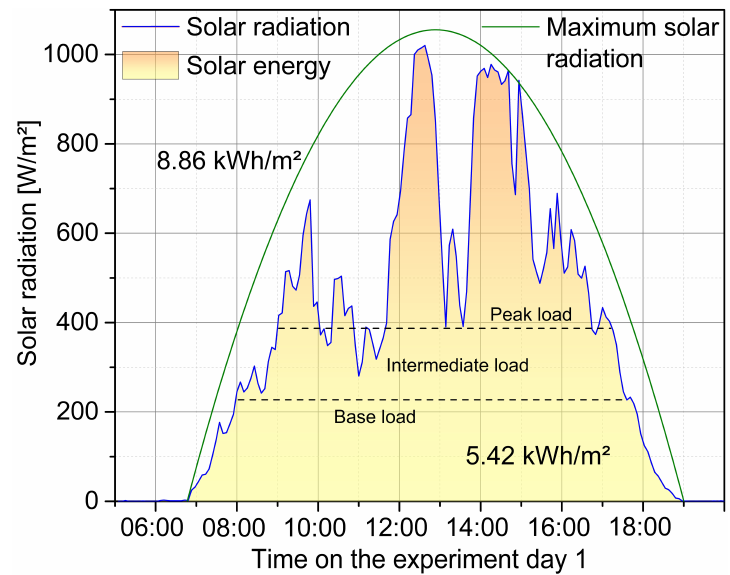
Figure 2. Measured, areal normalized solar radiation power at the site of the plant. The highest recorded value was 1020 W / m 2 . Over the entire day considered, with a total sunshine duration of approximately twelve hours, the solar radiation energy was 5.42 kWh / m 2 . Three weather- and daytime-dependent zones could be identified. The base load up to a power of 225 W / m 2 was available over a time period of ten hours. The intermediate load up to a power of 390 W / m 2 was available for about eight hours and the exceeding power was allocated to the peak load. As the maximum daily energy input under optimum conditions, a value of 8.86 kWh / m 2 was approximated by the green parabola.